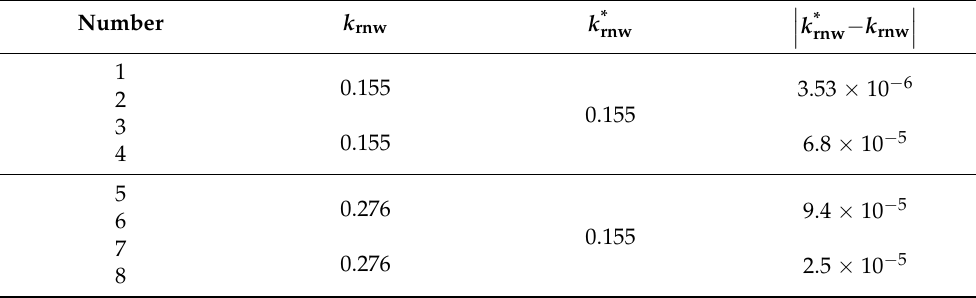
Table 10. The experimental data of Moghaddam is corrected for the end effect. Comparison of Moghaddam’s method and the relative permeability correction result of the stability factor method. Number k